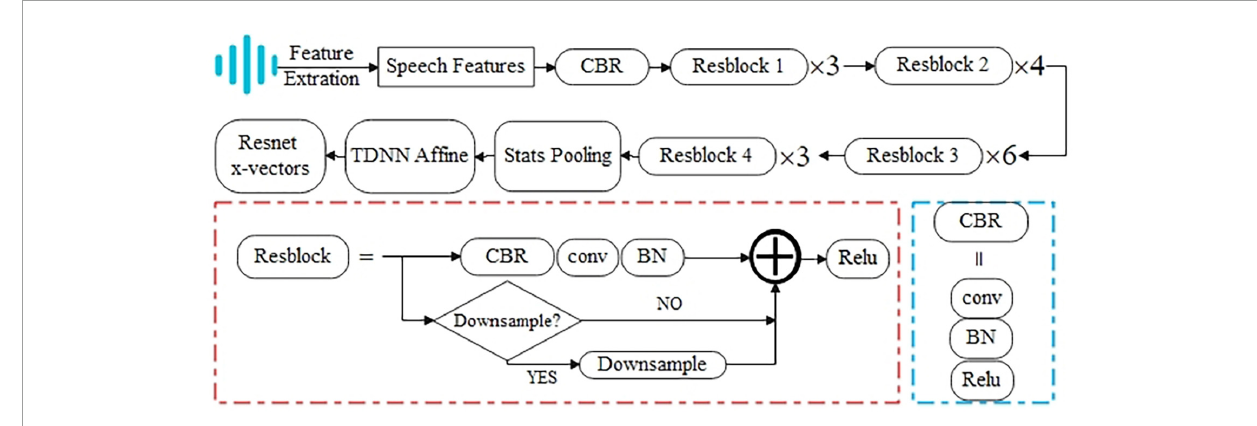
FIGURE2 The block diagram of the Resnet x-vector extraction